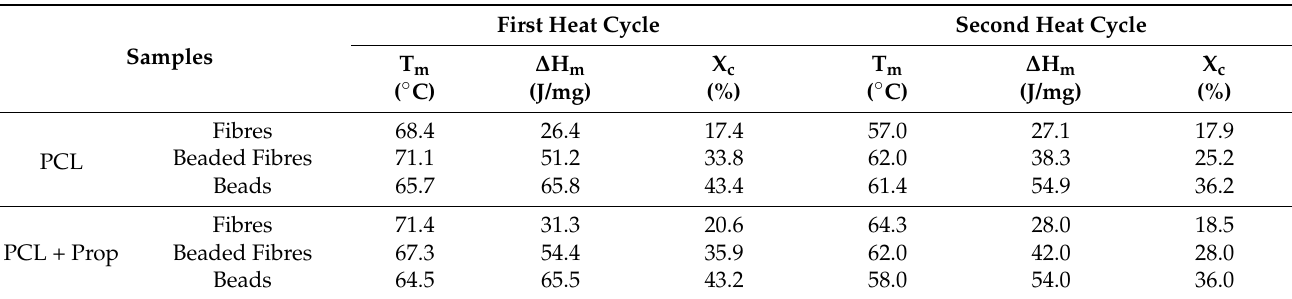
Table 3. Thermal transitions refer to the heating and cooling cycles of PCL and PCL + Prop for the different